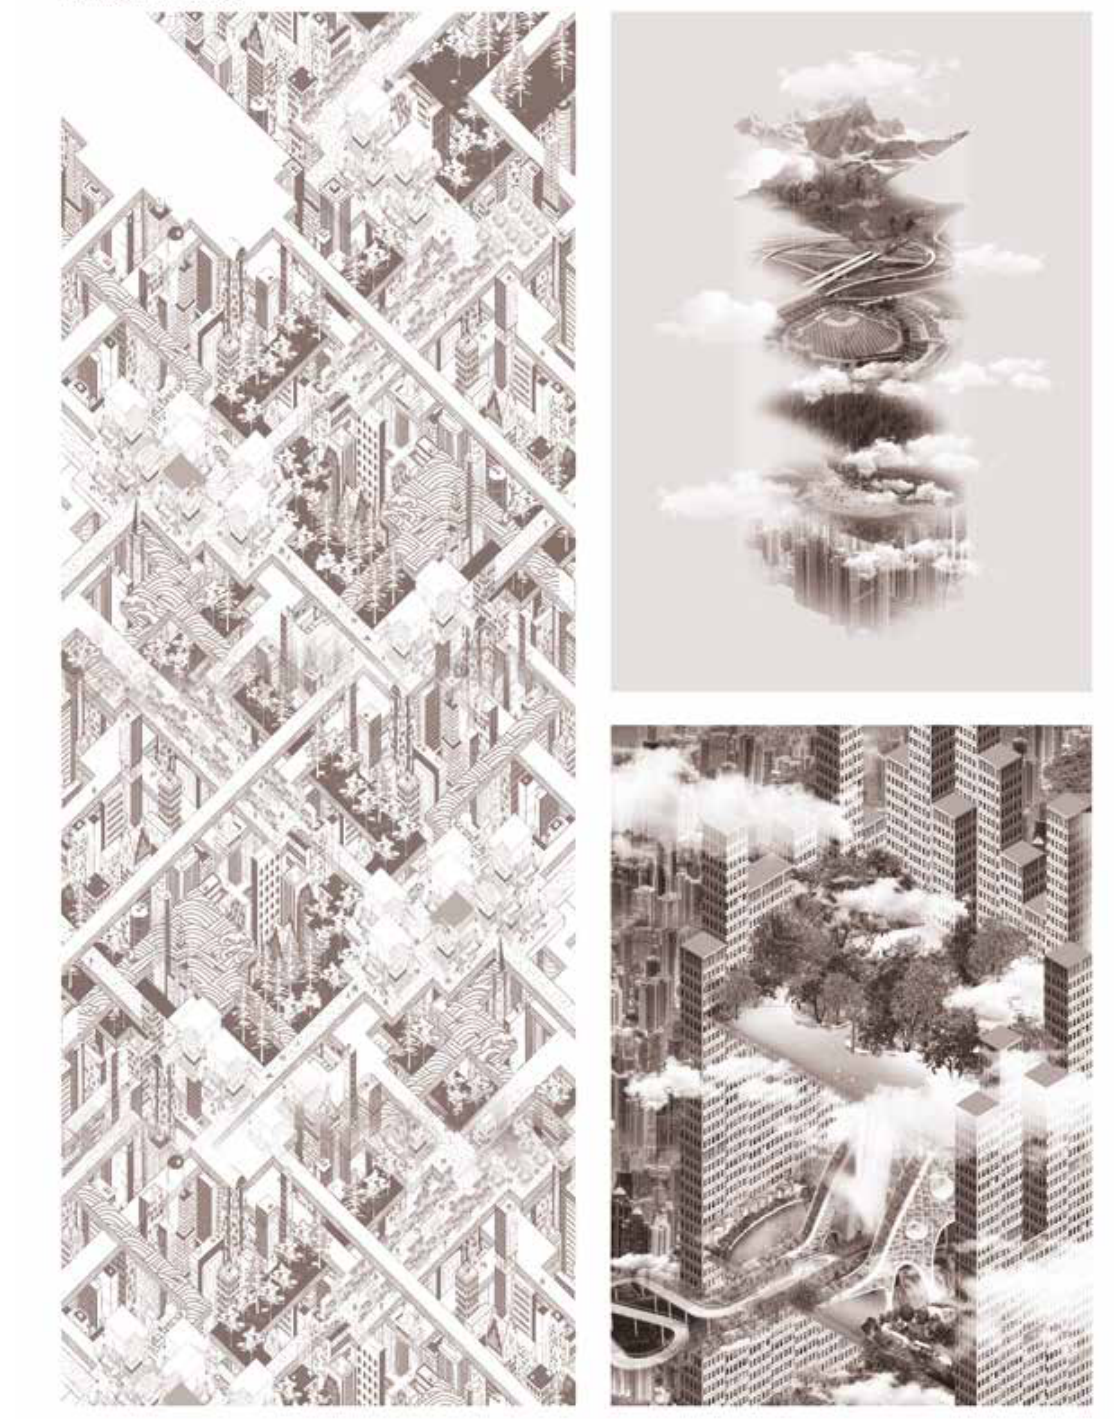
Figure 1: Chapter 1, Escape And Create. The story outlines the beginning of the escape to the not-yet-existing Fifth Region from the chaos and darkness of the street. Source: Lucas